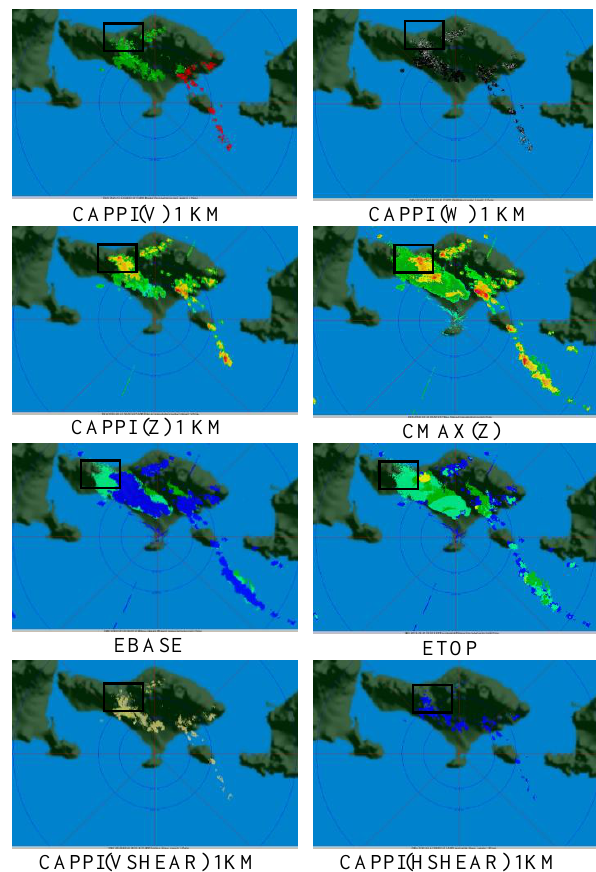
Figure 5. Radar product at whirl wind occurence in